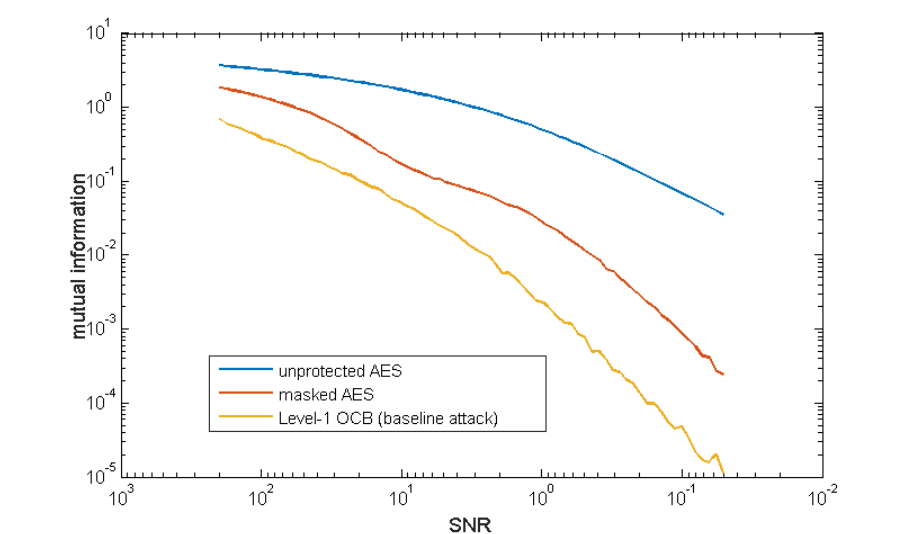
Figure 3: Attacks against masking vs. with unknown inputs: information theoretic